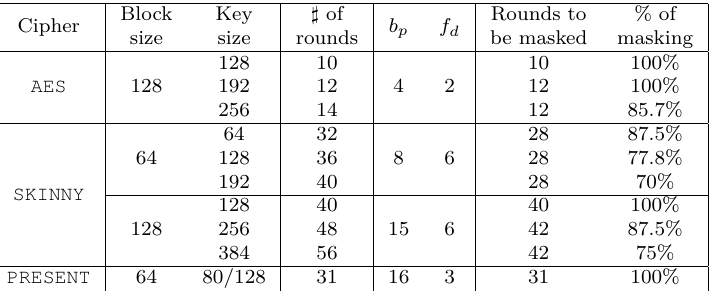
Table 5: Number of rounds to be masked for various